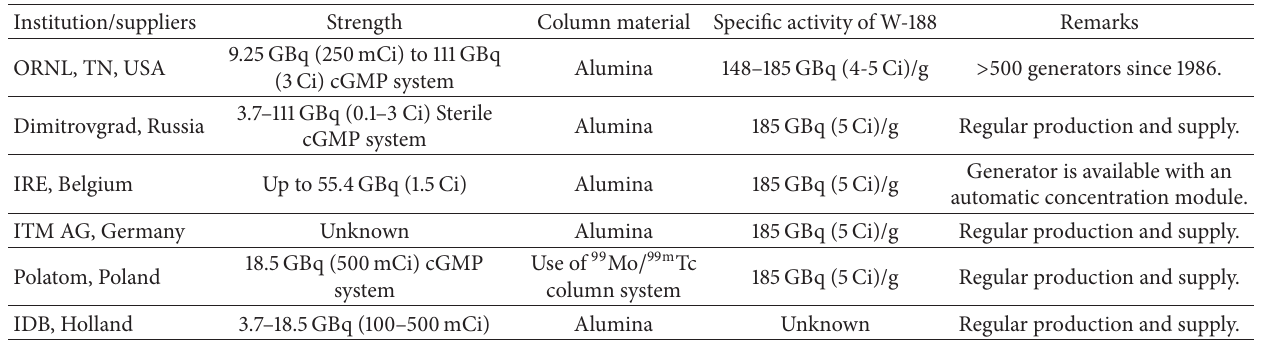
Table 2: The characteristics of the commercial 188 W/ 188 Re